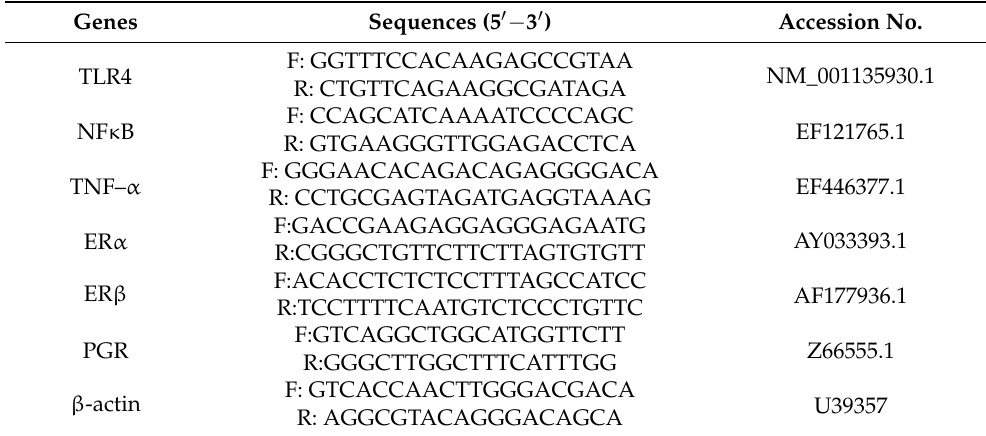
Table 1. Forward and reverse